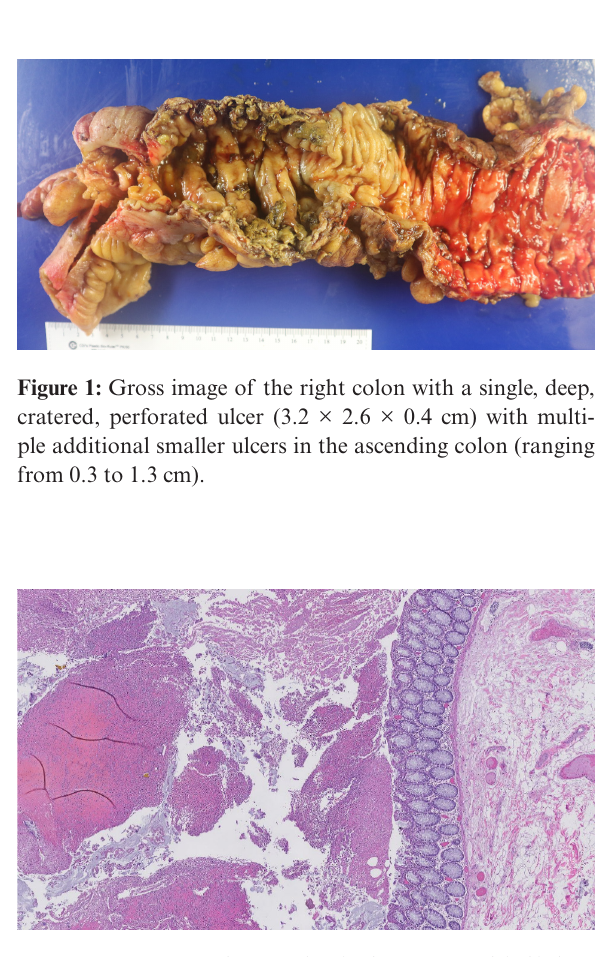
Figure 2: Low power image of colonic mucosa with fibrino- purulent exudate and crystals (Hematoxylin and eosin, 2× magnification).